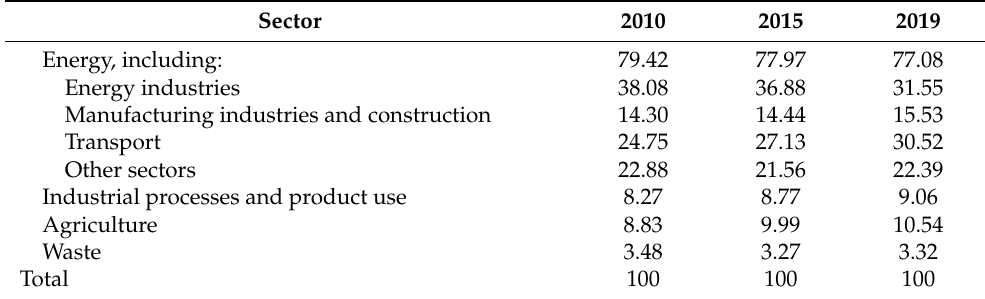
Table 2. Greenhouse gas emissions in the European Union countries, by sector